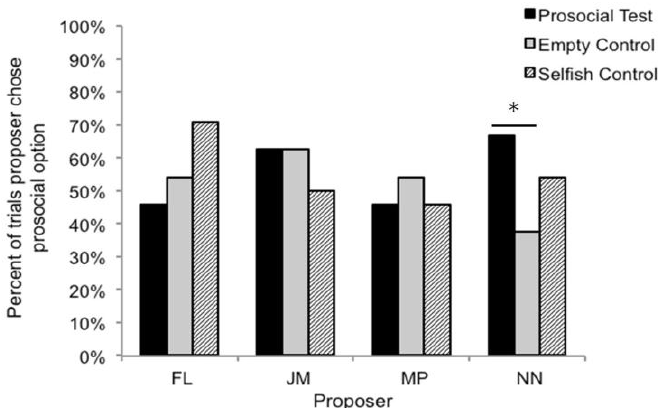
Figure 5. Percent of trials each actor selected the prosocial choice (1/1) when presented with the choice between 1/1 and 1/0 in the three conditions. Asterisks denote when an actor’s behavior was significantly different between conditions.